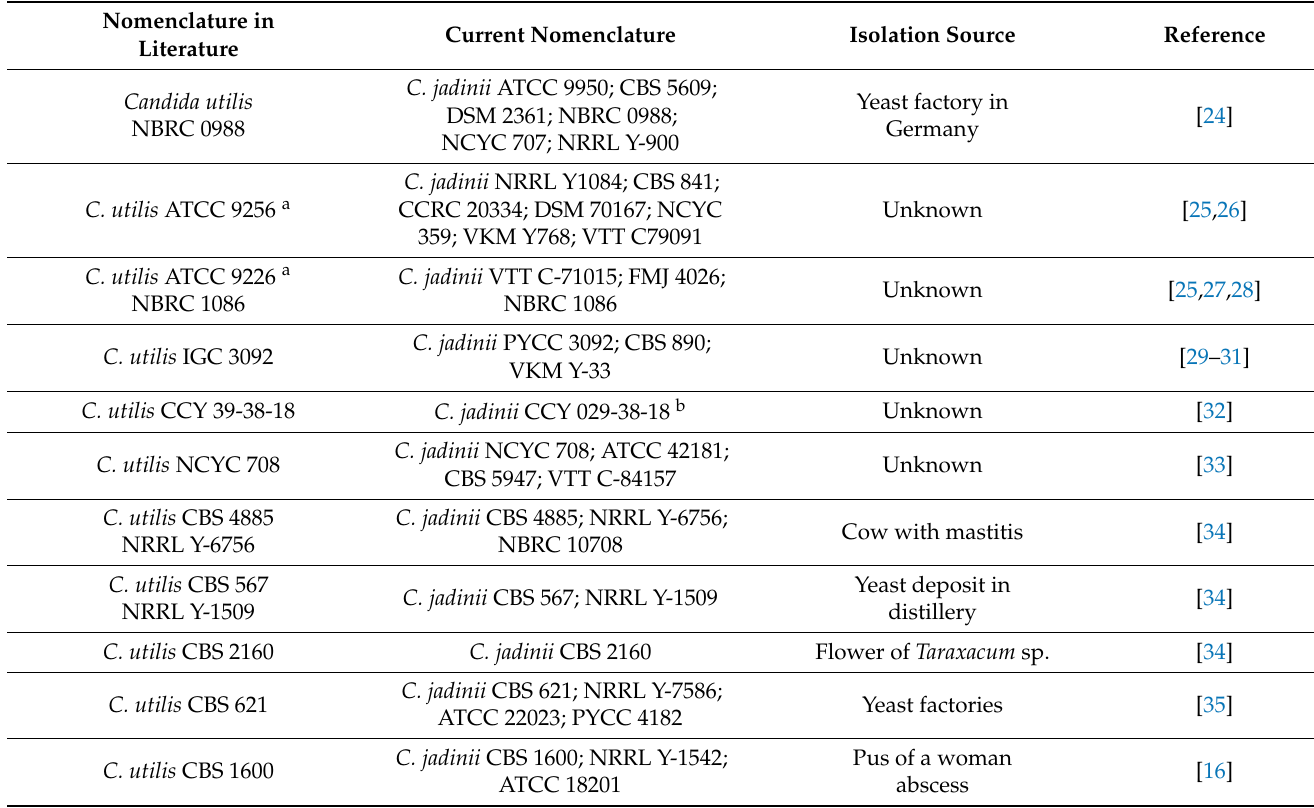
Table 1. Main C. jadinii (former C. utilis ) strains described in